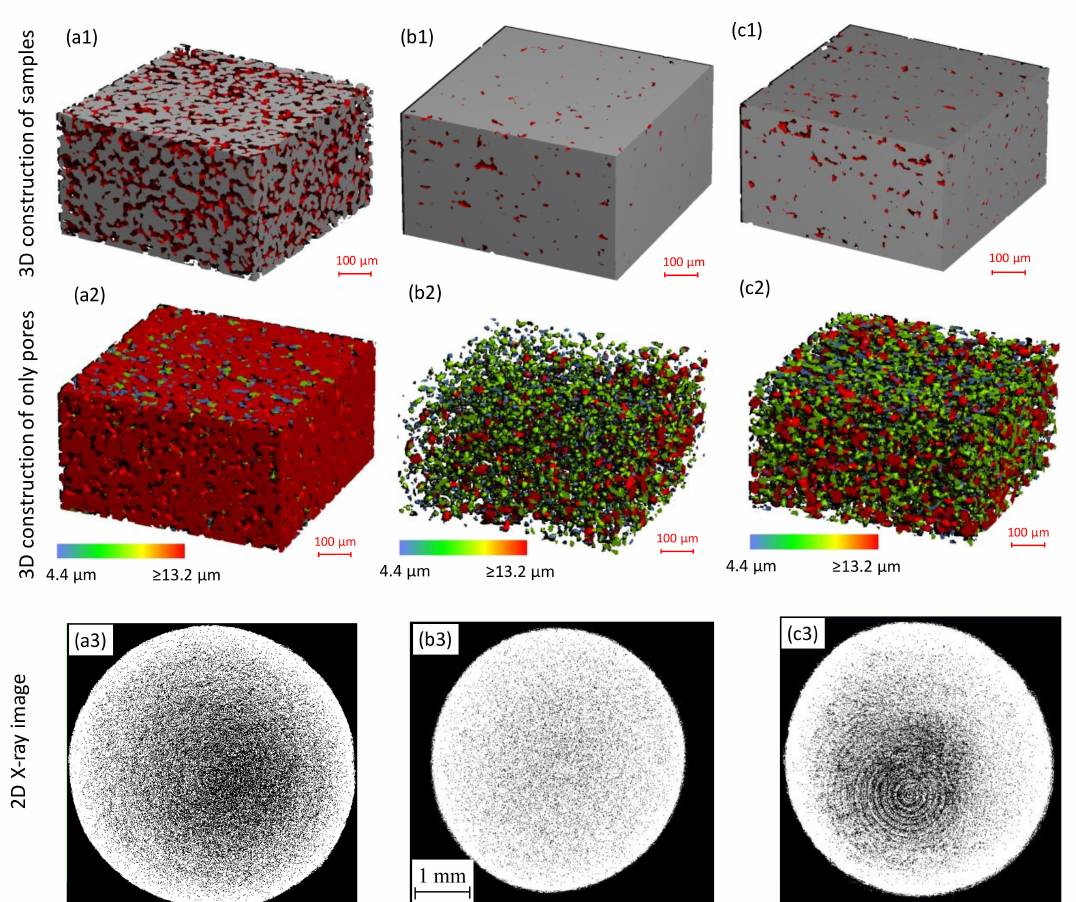
Figure 8. 3D reconstruction of the components for St ( a1 ) 950 ◦ C; ( b1 ) 1150 ◦ C; and ( c1 ) 1350 ◦ C, at Hr —10 ◦ C/min and Ht— 60 min. The visualization of pores at the above three temperatures are shown in ( a2 , b2 , c2 ). The corresponding 2D X-ray images are shown in ( a3 , b3 , c3